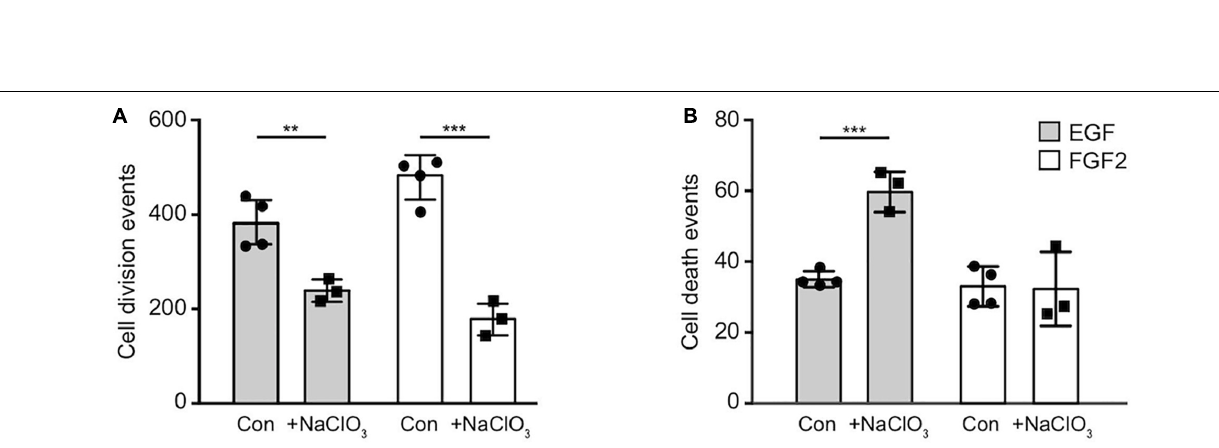
FIGURE 3 | Inhibition of sulfation reduced the cell division both in response to EGF and FGF2 and increased cell death in an EGF-dependent manner. The total number of cell divisions and events of cell death was analyzed over a period of 2.5 days recorded by time-lapse video microscopy. (A) There was a strong reduction in the number of cell divisions of spinal cord progenitors exposed to either EGF or FGF2 caused by exposure to chlorate. (B) Cell death rates of progenitors appeared enhanced when treated with chlorate in the presence of EGF. Error bars indicate SD, ** p ≤ 0.01, *** p ≤ 0.001 ( t -test); N = 3.